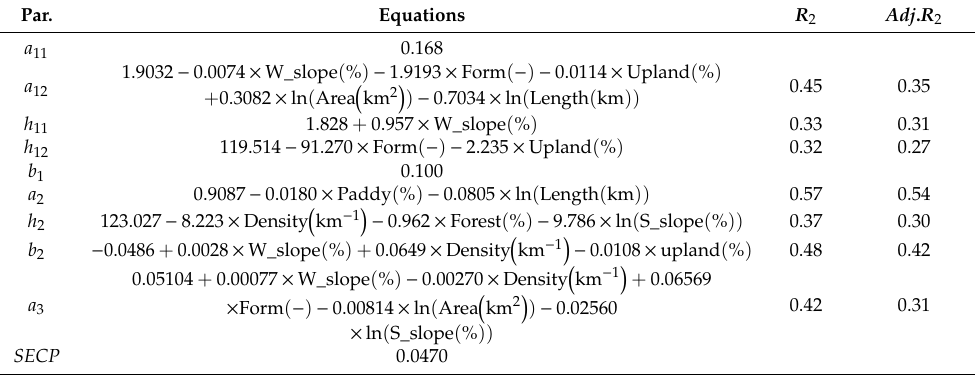
Table 5. The 3-Tank model parameters regionalized based on the results of calibration implemented with optKGE (cid:48) sqrt